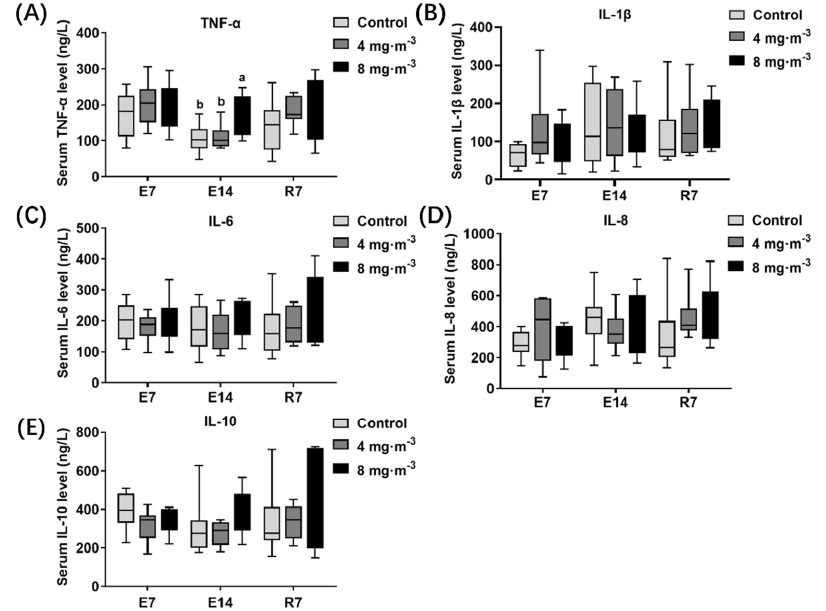
Figure 4. Effects of particulate matter exposure on inflammatory factor levels in serum of broilers. ( A – E ) represent the TNF-α, IL-1β, IL-6, IL-8, and IL-10 levels in serum of broilers after E7, E14, and R7, respectively. Data are presented as mean ± SEM of groups (n = 8). Different letters indicate statistically significant differences between groups ( p < 0.05). E7, exposure for 7 days; E14, exposure for 14 days; R7, recovery for 7 days.